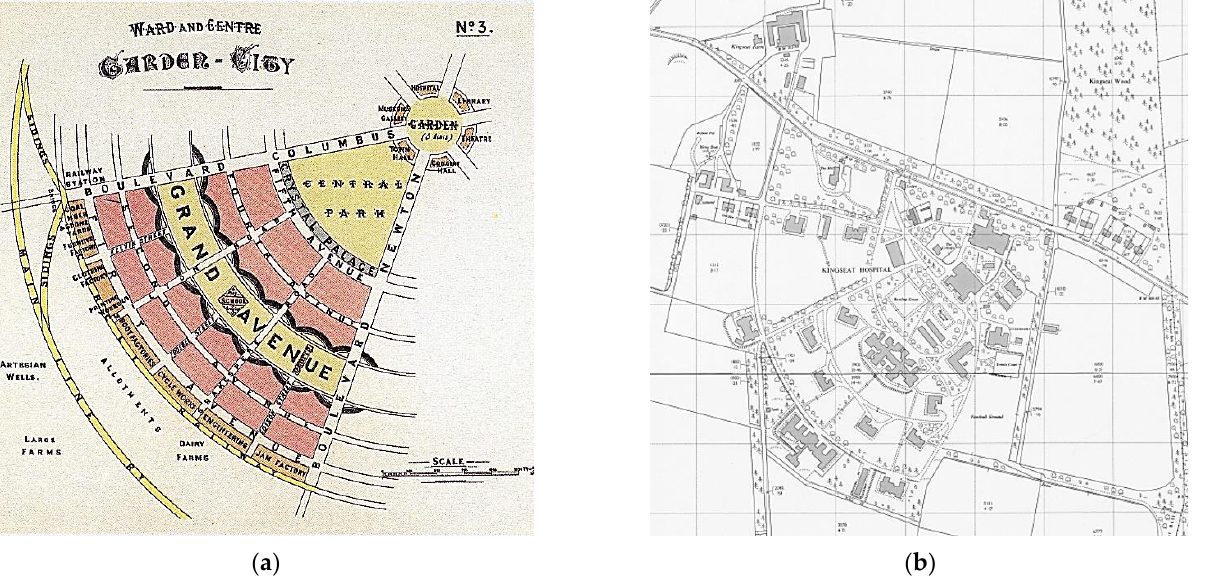
Figure 1. Similarities in plans between the garden city diagram and the plan of a mental asylum of the early 20th century: ( a ) Diagram No. 3 by Ebenezer Howard showing the ward and centre of the garden city (from Howard, Ebenezer, To-morrow: A Peaceful Path to Real Reform , London: Swan Sonnenschein & Co., Ltd., 1898; source: [10] public domain, ( b ) The plan of the Kingseat Asylum in Scotland, built from 1900 to 1904, as pictured on the Ordnance Survey Map from 1944; source: the collection of the National Library of Scotland, CC-BY (NLS).